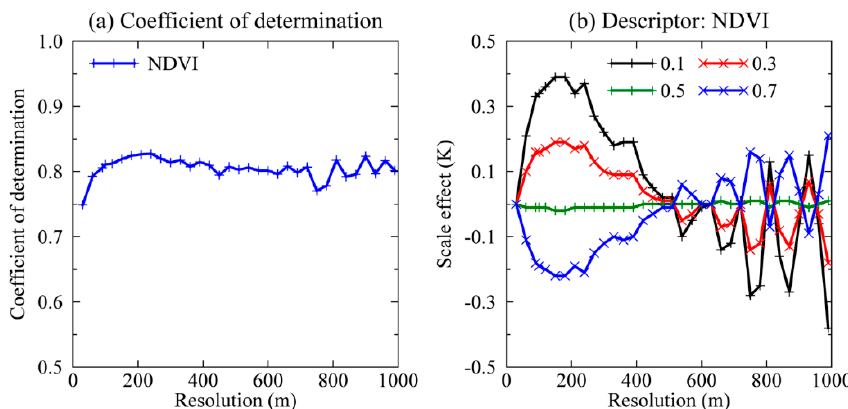
Figure 9. ( a ) R 2 in training the regression function of LST-NDVI and ( b ) the quantified scale effect at different NDVI values based on the Tiangong-1 simulated LSTs.